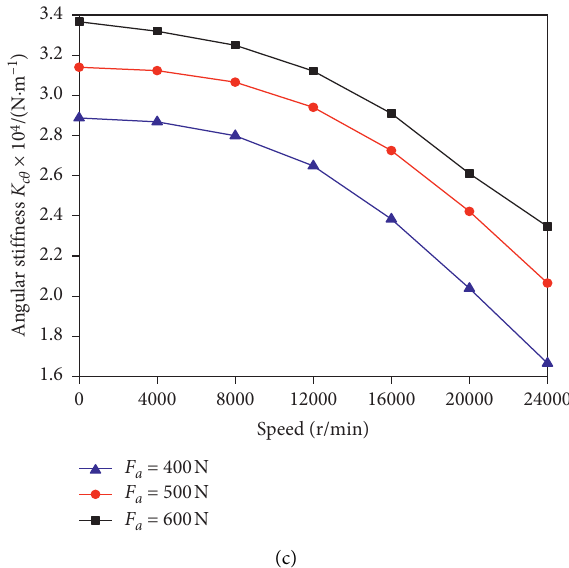
Figure 17: Influences of the speed and preload on contact stiffness. (a) Radial stiffness. (b) Axial stiffness. (c) Angular